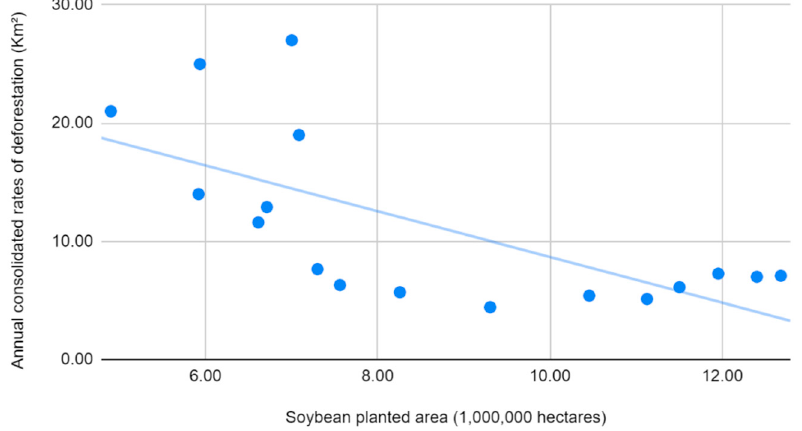
Figure 14. Correlation chart: consolidated annual rates of deforestation and soybean planted area.